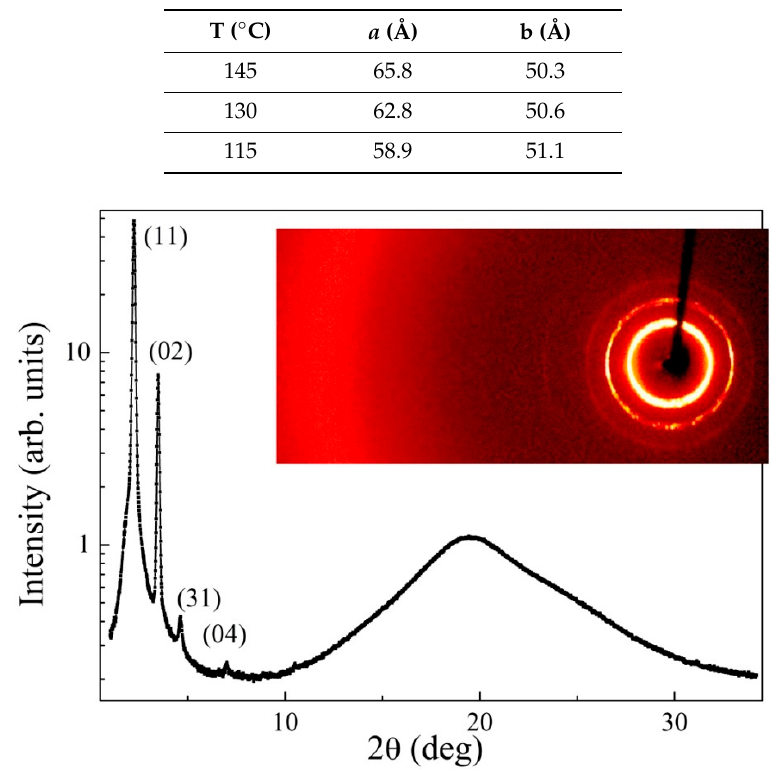
Table 2. Parameters of the centered rectangular unit cell in the B 1 phase detected by X-ray di ff raction (XRD) for 8BVJH12.